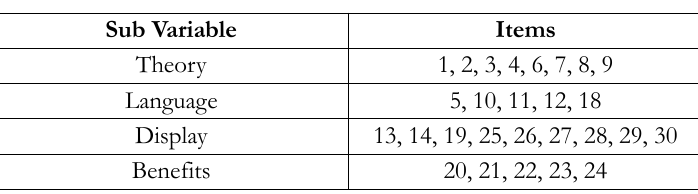
Table 1. Perception Instrument